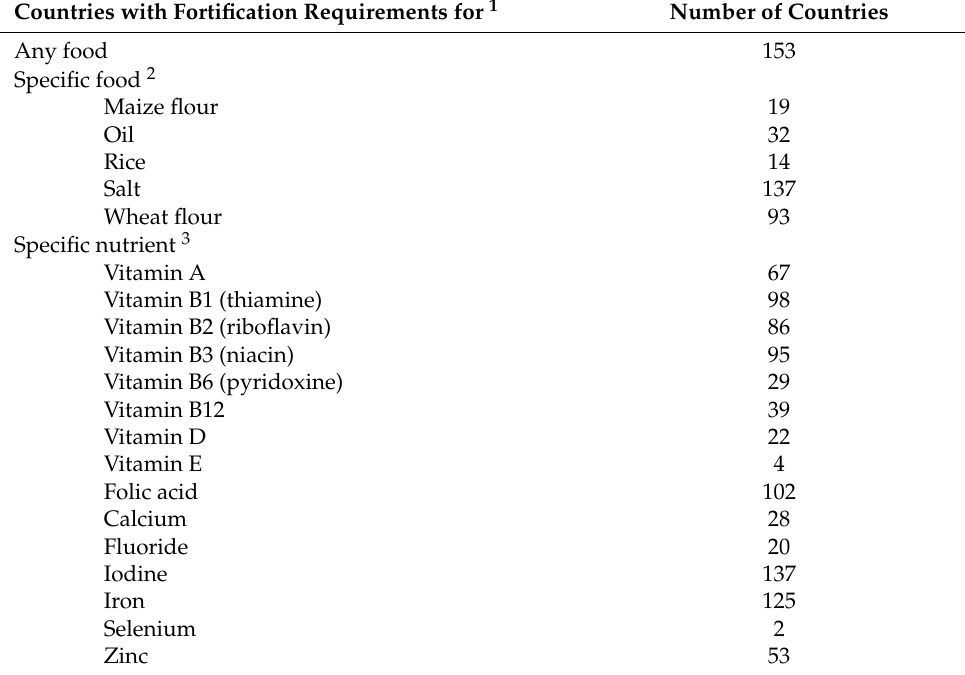
Table 1. Countries, foods, and nutrients included in the analyses (GFDx 2020).